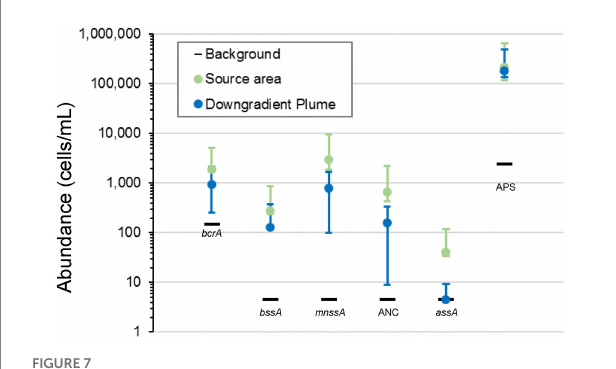
FIGURE 7 Site 2 abundance of functional genes in background, source area, and downgradient plume monitoring wells related to anaerobic degradation of PHC. The mean abundance for functional genes in source area and downgradient plume monitoring wells is represented by the green and blue circles, respectively, and the data spread (maximum and minimum) is represented by the error bars. The measured abundance for functional genes in the background monitoring well is represented by the black horizontal bars. Abundances of functional genes related to PHC biodegradation in source area and downgradient plume monitoring wells are several OoM greater than abundances in the background monitoring